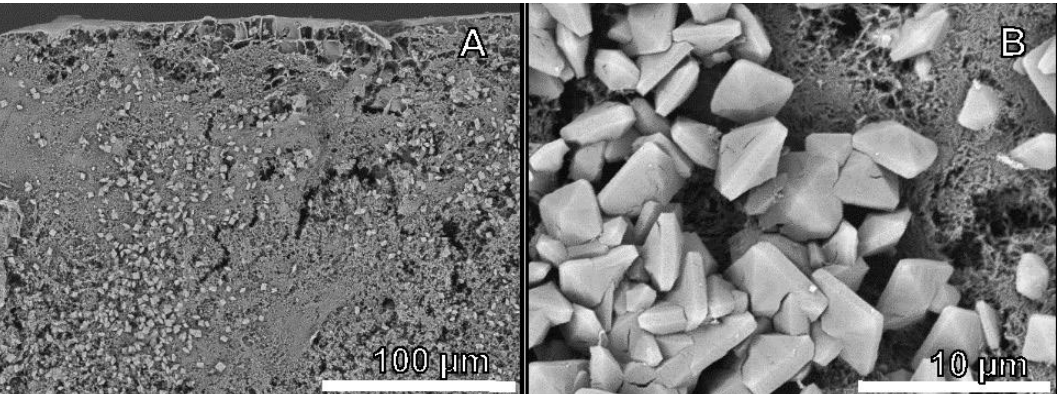
Figure 6. Scanning electron micrographs of calcium oxalate crystals found in 44 DAFB orange fruits. Oxalate crystal distribution in the fruit rind ( A ) and crystal morphology ( B ).